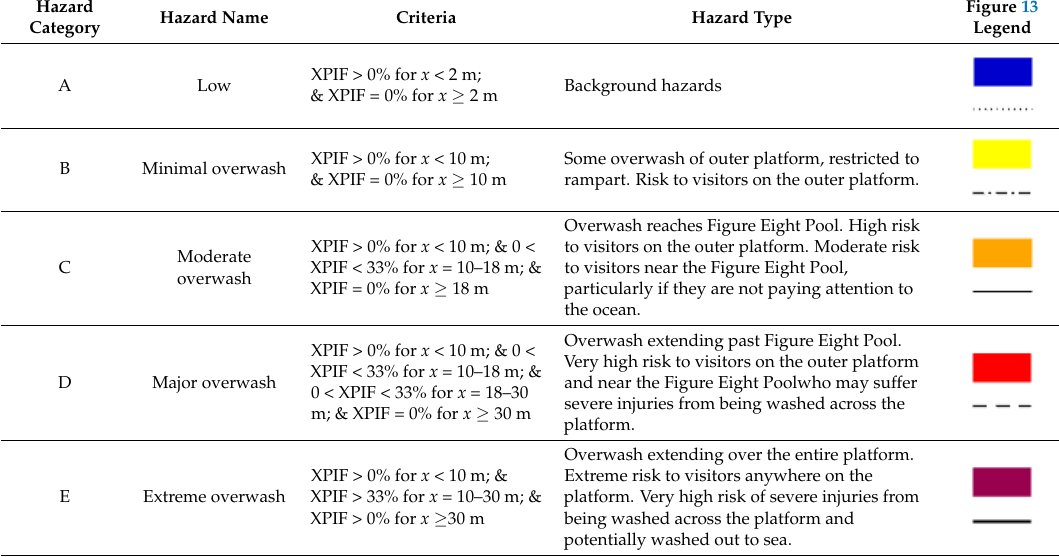
Table 2. Definitions of the five hazard categories defined for the N2 transect on the Figure Eight Pools Rock Platform and the color and line styles used to delineate the categories in Figure 13.